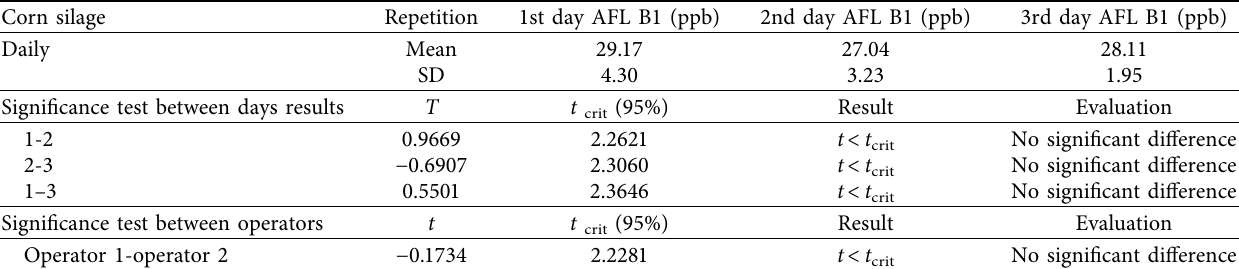
Table 4: Repeatability of the ELISA method for corn silage. Two operators measured AFL B1 in three repetitions on three different days from freshly prepared samples. SD, standard deviation. Spike: 35ppb AFL